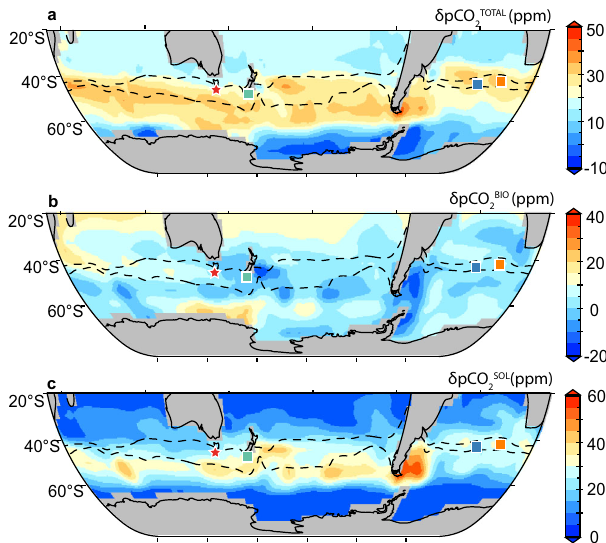
Fig. 4 | Southern Ocean surface-water pCO 2 changes in a climate model simu- lation during the last deglaciation 28 . a Total surface-water pCO 2 change ( δ pCO 2 TOTAL ). b surface-water pCO 2 change attributed to the biological pump ( δ pCO 2 BIO ). c , surface-water pCO 2 change attributed to the solubility pump ( δ pCO 2 SOL ). All anomalies ( δ ) represent changes between 19 ka and 15 ka. Note different δ pCO 2 scales for the three panels. The region between the dotted lines is the modern Subantarctic Zone (SAZ). The locations of MD97-2106 (red star) and other investigated sites (ODP 1090, orange square; PS2498-1, blue square; TAN1106-28 tealsquare) are shown. Ascan be seen, the total δ pCO 2 TOTAL rise in the SAZ from 19 to 15 ka in this model simulation is mainly driven by solubility pump changes.The fi gureismadefromrecalculationbasedondatapresentedinMenviel et al. 28